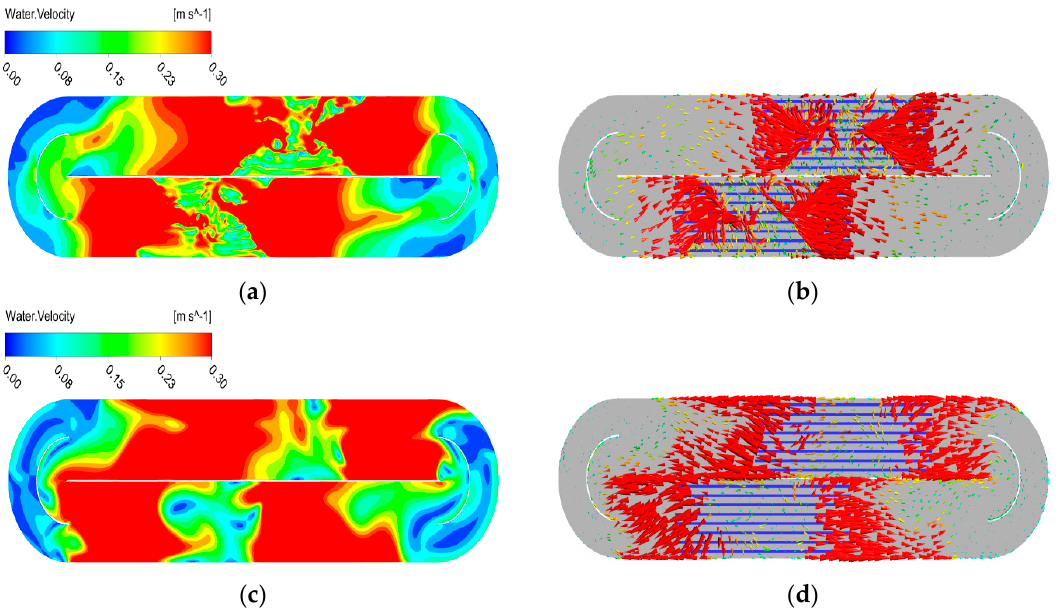
Figure 13. Water velocity contour (a,c) and water velocity vectors (b,d) on a horizontal plane at 0.5 and 6 m (from top to bottom) above the tank floor.